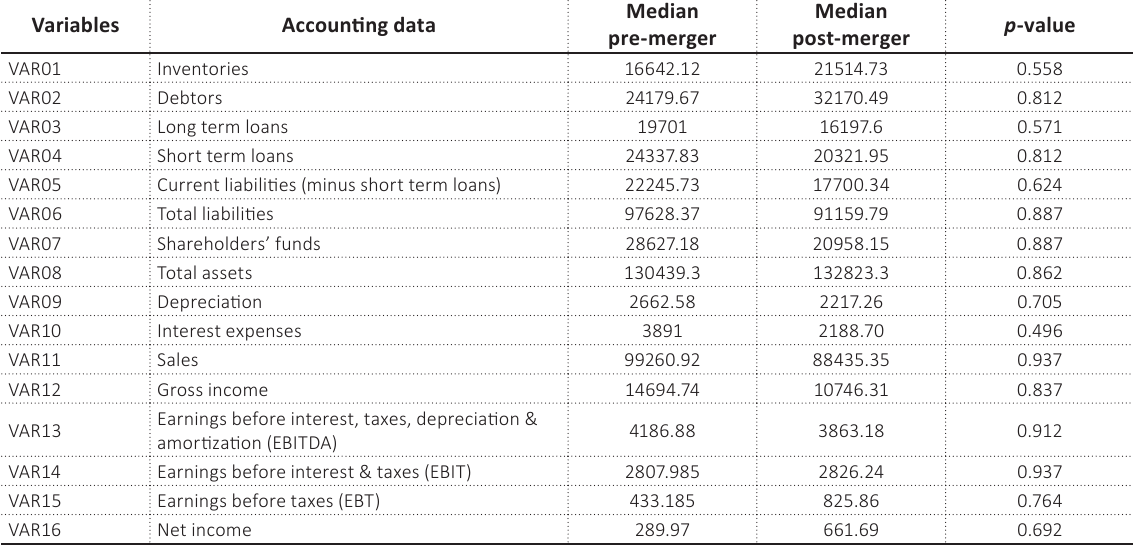
Table 3. Comparison of the median for 16 accounting measures from pre- and post-merger period with Mann-Whitney tests